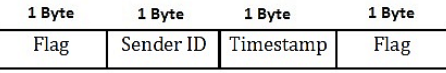
Figure 3. Request Packet Format.